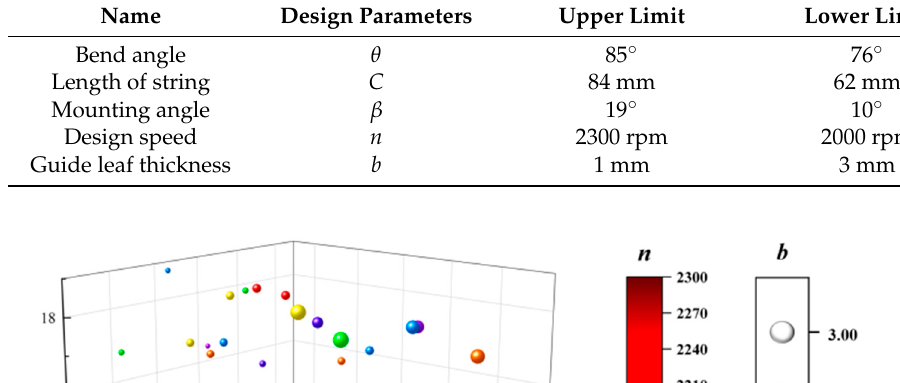
Figure 8. The correlation between optimization variables and optimization objectives. Table 1. The value range of design parameters.